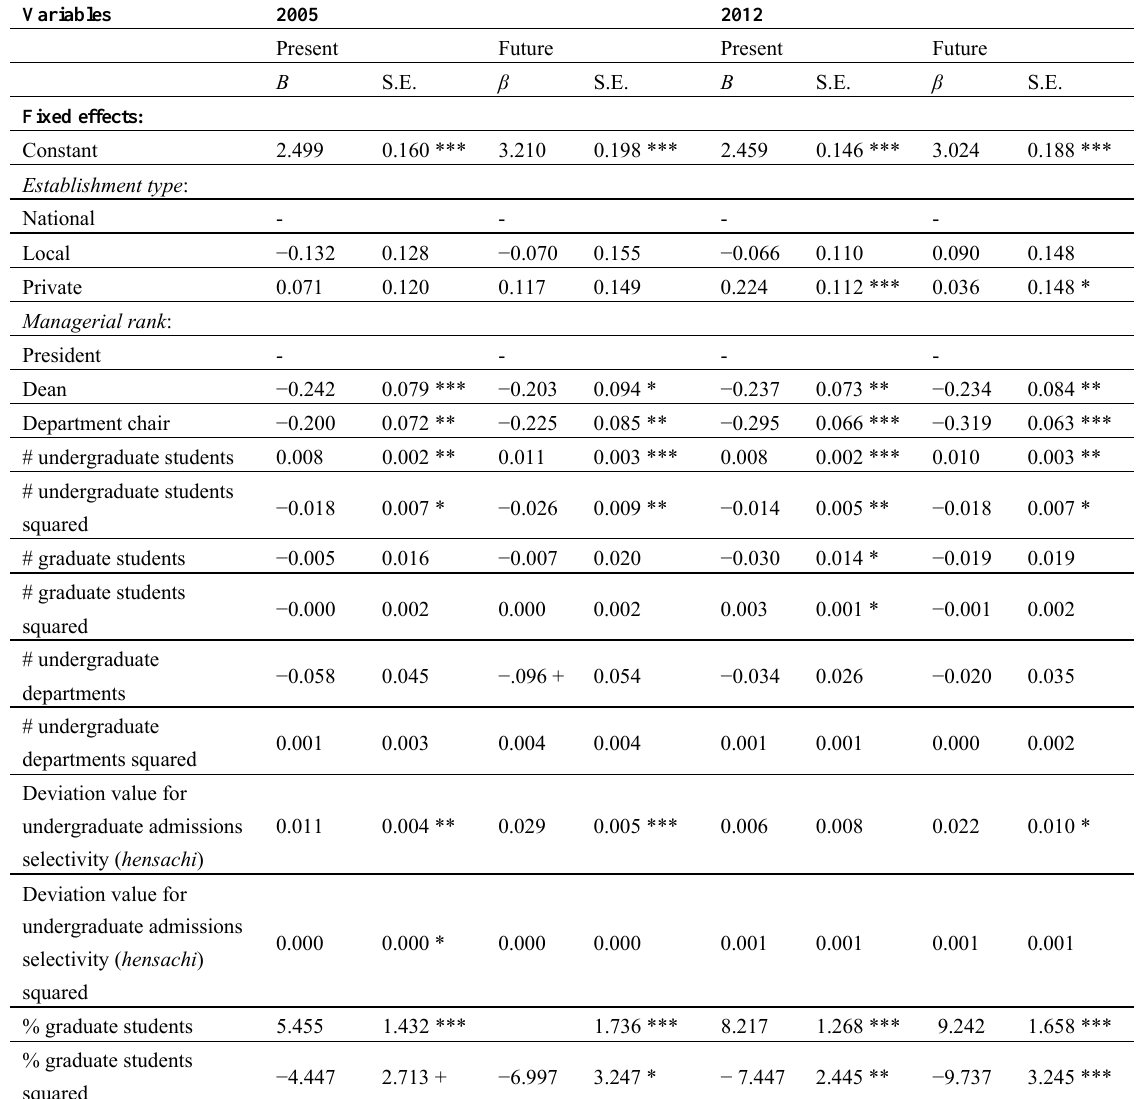
Table A1. Determinants of rating with positive perceptions on becoming a global academic base.